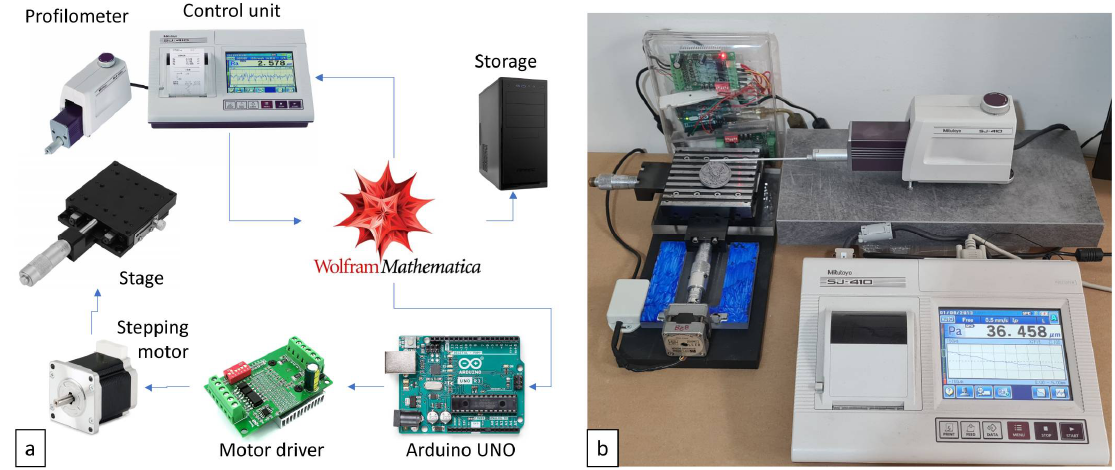
Figure 1. Framework of the system ( a ) and measurement layout ( b ).